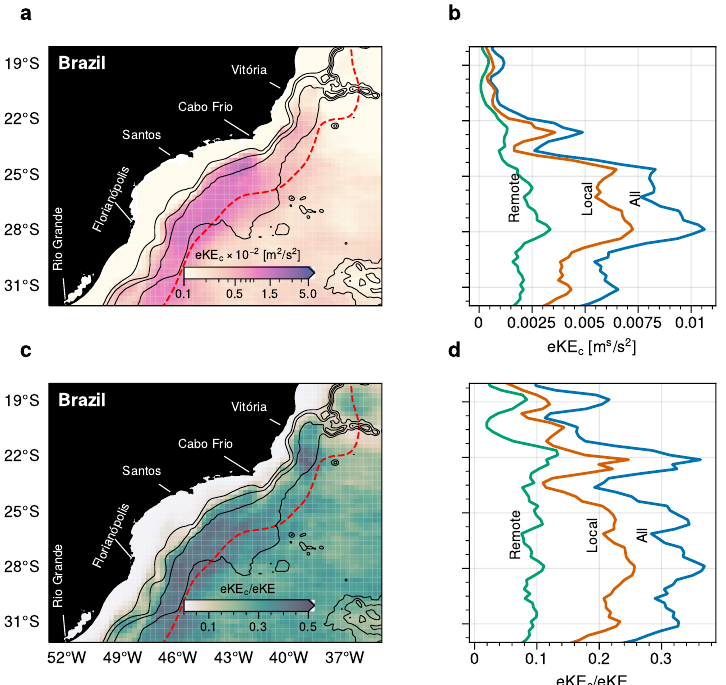
Figure 4. ( a ) Kinetic energy due to compact, closed-conttour eddies ( EKE c ) and ( c ) its ratio to the total eddy kinetic energy. ( b ) The zonal average of EKE c (blue line) within the Brazil Current domain, defined as the region west of the dashed red curve, and its breakdown into local (orange) and (green) remote eddies. ( d ) Similar to ( b ) but for the energy fraction ( EKE c / EKE ). Solid black lines in ( a , c ) depict the 200, 1000, 2000 and 3000-m